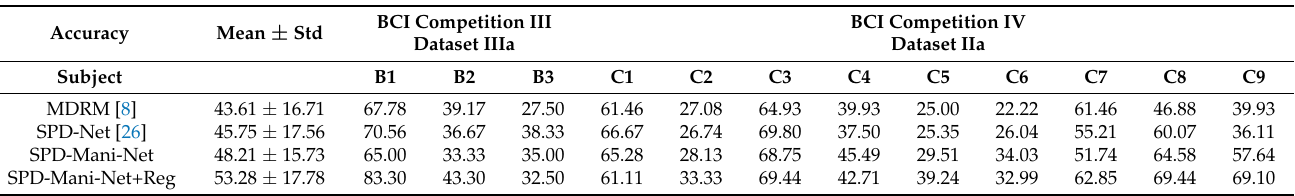
Table 5. Classification accuracies for the EEG datasets from motor image multi-subject BCIs.